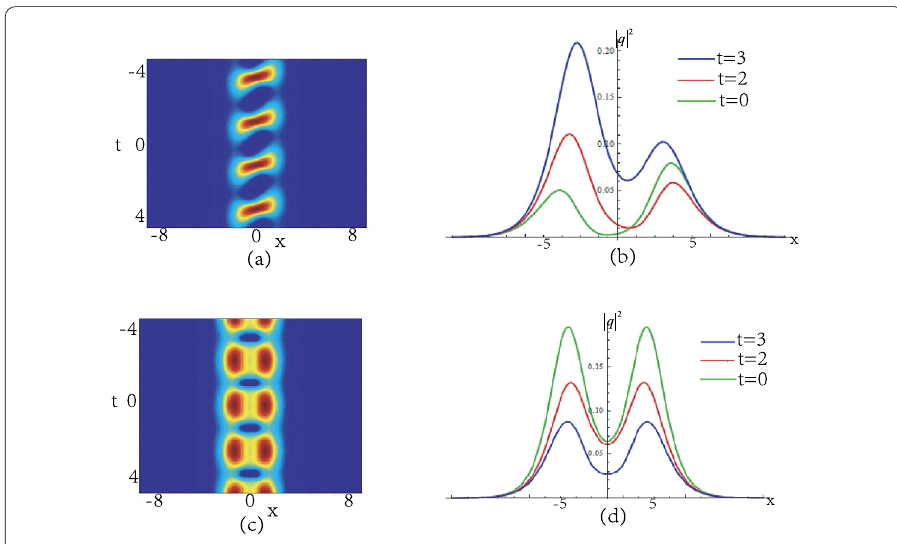
Figure 2 Interaction of the two-soliton solution for the nonlocal two-place DNLS equation (23). Pictures ( a ) and ( b ) show the interaction of the two-soliton for η j 0 R = 0, η 10 I = 1 and ( d ) illustrate the interaction of the two-soliton for η j 0 R = log kj k 1 R = –1, k 1 I =